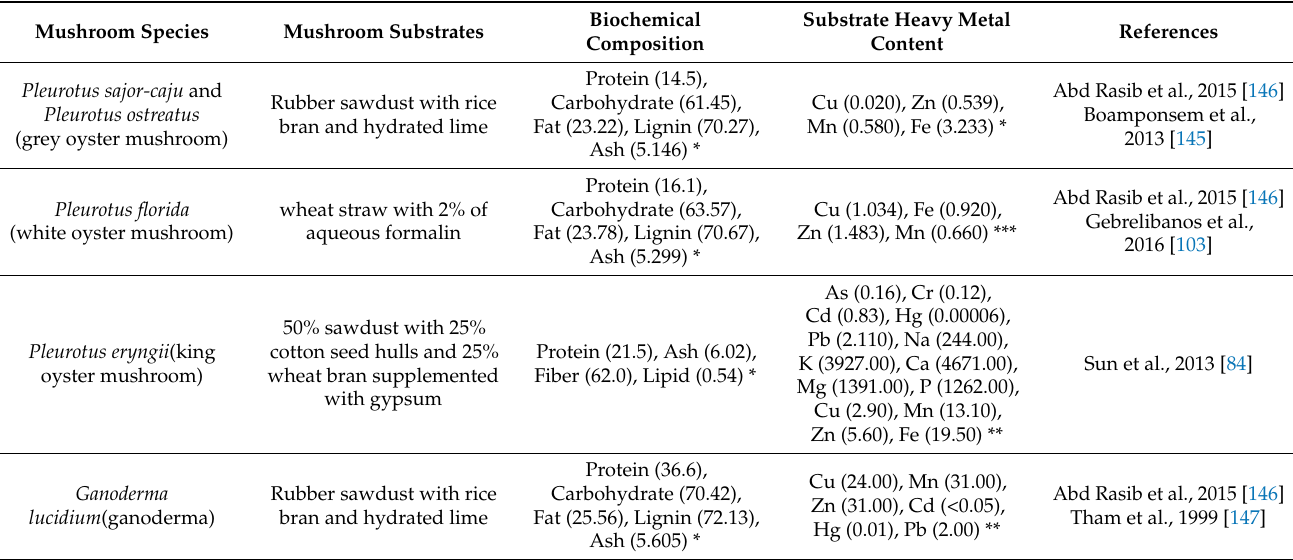
Table 6. Chemical and heavy metal composition in commercial mushroom